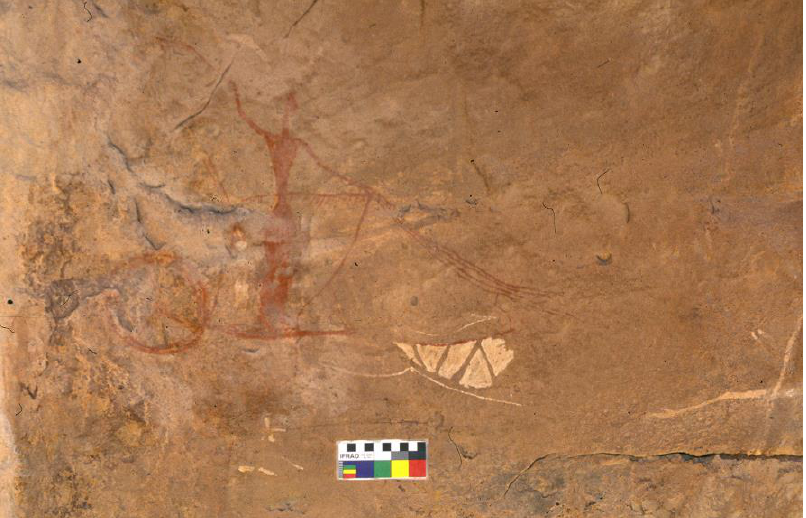
Figure 6. Painted chariot in Bitriangular/Horse style, in T-Afozzigiar-t rockshelter.